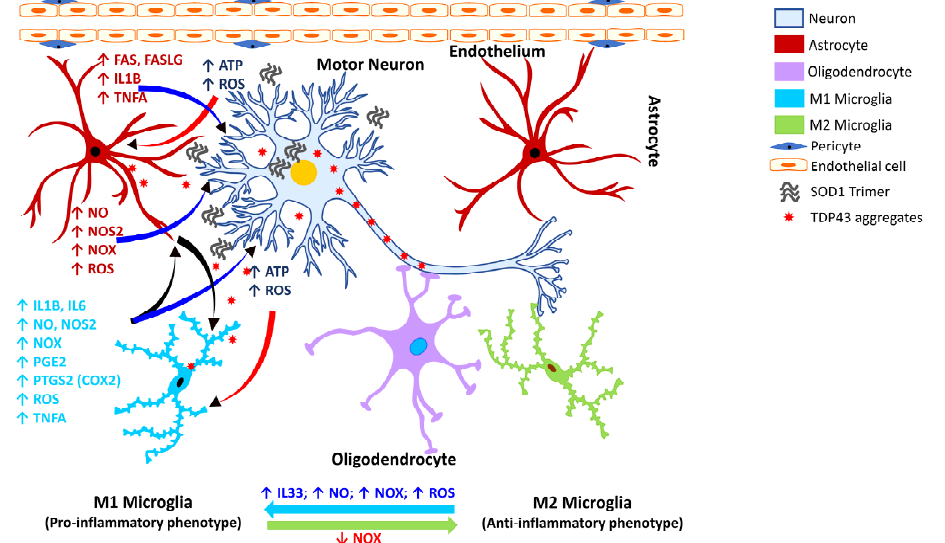
Figure 4. Inflammatory cascade in Amyotrophic Lateral Sclerosis. Schematic representation of the molecular mechanisms associated with glia ‐ mediated functional interactions and systematic pertur ‐ bations within the CNS to induce neuroinflammation in Parkinson’s disease. The endothelial cells form the inner lining of the blood vessel with pericytes enveloping the surface of the vasculature forming tight junctions to maintain the BBB integrity. Upon insult, the augmented production and release, as well as impaired clearance of mutant SOD1 trimers, TDP43, and ubiquitin aggregates sustains chronic activation of the primed microglia resulting in the production and release of pro ‐ inflammatory mediators, including free radicals, cytokines, and chemokines, thereby affecting the resident CNS cells (astrocytes, oligodendrocytes, and neurons) and leading to disruption of nuclear ‐ cytoplasmic transport, ubiquitination and accumulation of TDP43 in the cytoplasm, aggregation of SODI trimers, and subsequent neuronal injury/damage. M1 microglia (proinflammatory phenotype, neurotoxic) release various proinflammatory mediators including free radicals, cytokines and chem ‐ okines that further stimulate other glial cells and collectively contribute to exacerbating the neuronal injury/damage. M2 microglial cells (anti ‐ inflammatory phenotype, neuroprotective) can polarize to an M1 state and release proinflammatory mediators in the presence of increased levels of NOX, ROS, NO, and IL33 released by M1 microglia and/or astrocytes and thereby augment the neuroin ‐ flammatory and neuronal injury process leading to synaptic dysfunction, neuronal injury, and neu ‐ ronal death. Astrocytes respond by releasing proinflammatory mediators, including free radicals, cytokines, and chemokines, which further contribute to enhancing the endothelial permeability, dis ‐ rupting BBB integrity, and allowing for infiltration of peripheral immune cells, events that further intensify inflammation and neuronal injury. Feedback regulation of NOX or its inhibition causes M1 microglia to polarize to the M2 state (anti ‐ inflammatory phenotype), which downregulates M1 func ‐ tions and promotes regulation of neuroinflammation and neurorepair by releasing anti ‐ inflamma ‐ tory mediators, e.g., cytokines, neurotrophic, and growth factors. Mediators released by specific neural cell types (neuron, astrocyte, microglia or oligodendrocyte) are listed adjacent to each cell type in similar colored text. Curved arrows indicate the direction of signal flow between various neural cells for the inflammation activation process. Red curved arrows show the directional flow of danger/damage signals from neurons to glial cells (astroglia, microglia, oligodendroglia); blue curved arrows show the flow of proinflammatory signals from astrocytes and M1 microglia towards distressed neurons; green curved arrows show the flow of neurotrophic signals from M2 microglia and oligodendroglia towards the distressed neurons as a neuroprotective/neurorescue endeavor; black curved arrows show the directional crosstalk among various glial cells to mount a glial re ‐ sponse to neuronal injury/damage. ↑ , increase; ↓ , decrease; ATP, adenosine triphosphate; BBB,